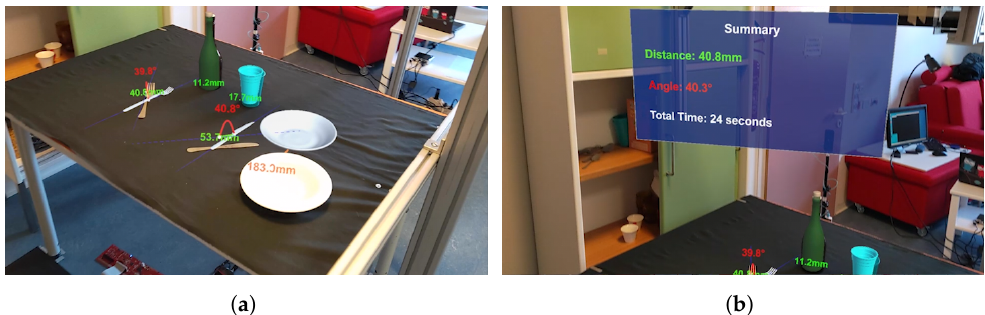
Figure 6. ( a ) Example of errors visualization in AR via therapist’s HoloLens 2 with ( b ) AR panel in which error averages and total time are